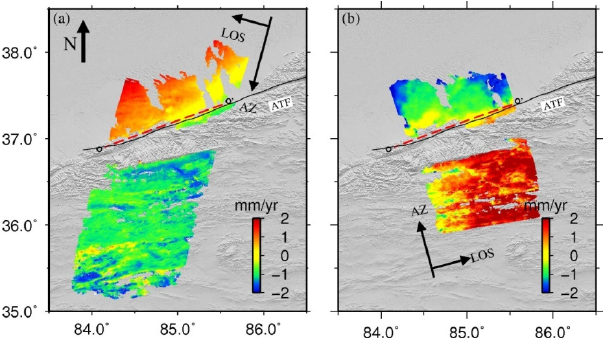
Figure 5. ( a ) Ground surface mean LOS velocity maps from InSAR time series analysis for D391. The fat black arrow shows the north direction. The dashed line indicates the fault location used for the 2-D modeling. The OO 1 line stands for the fault location. ( b ) Ground surface mean LOS velocity maps from InSAR time series analysis for